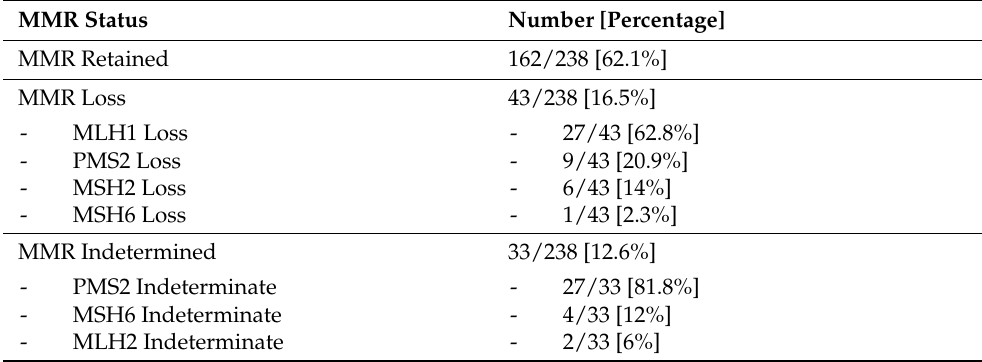
Table 1. MMR expression in endometrioid endometrial cancer.